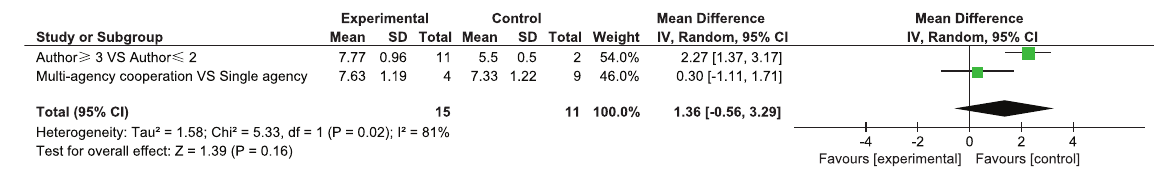
Figure 2. Analysis of the influencing factors of methodological quality of the included studies. Note: Group A is the group with number of authors ≥ 3; multi-agency cooperation; Group B is the group with number of authors ≤ 2; single